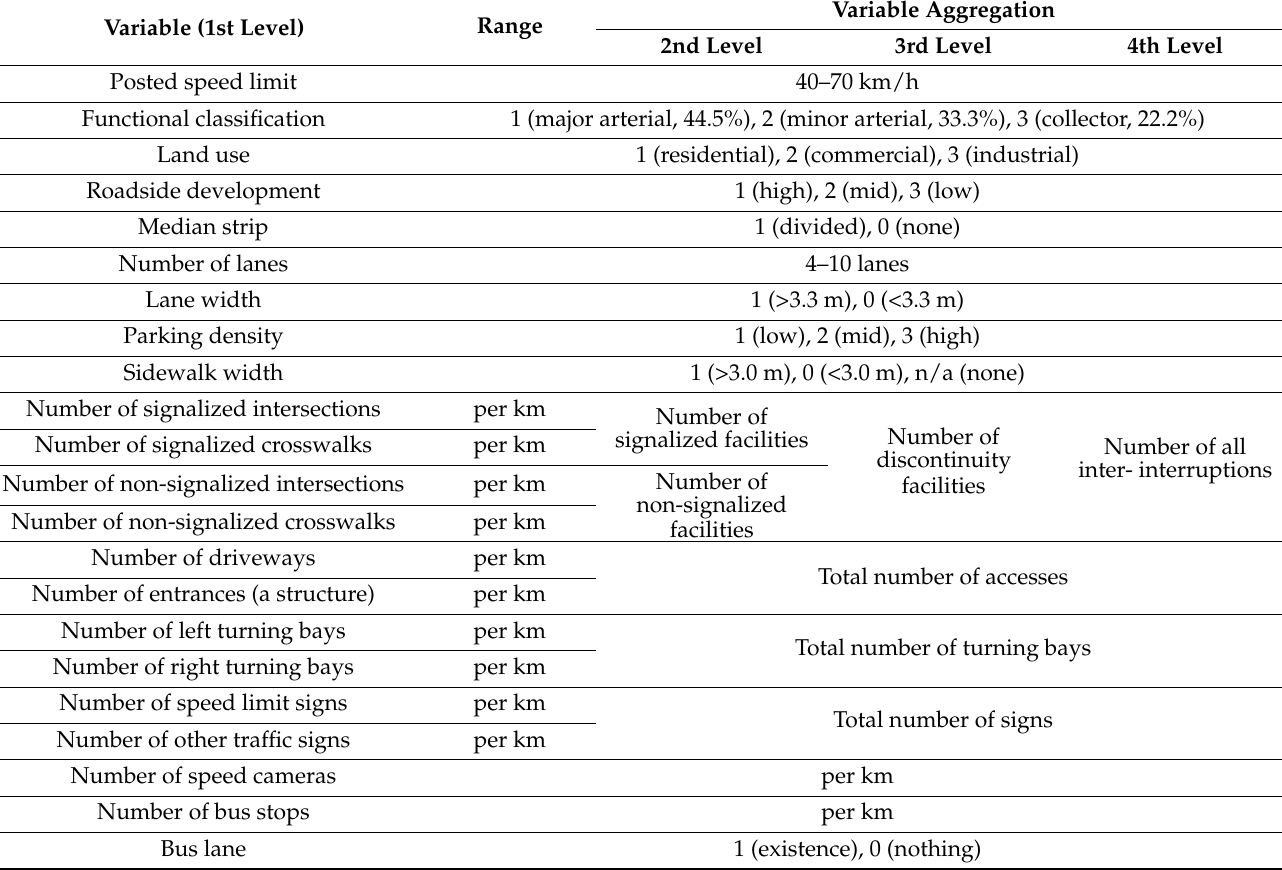
Table 7. Speed affecting variables investigated in the